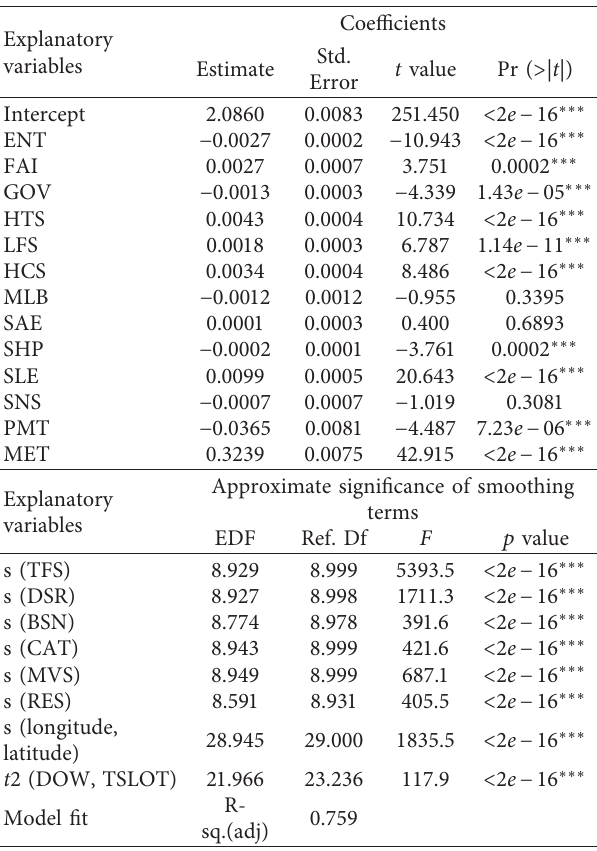
Figure 5: Distribution of taxi vacant time of grids.(a) Kernel Density Estimation. (b) Empirical Cumulative Distribution Function. Note: some outliers (top 1%) were removed to increase the readability of the plot; the vertical dashed line in Figure 5(a) is the average of the grid taxi vacant time, and the horizontal dashed line in Figure 5(b) is the dividing line of the cumulative frequency at 90%. Table 2: Estimation results of GAM